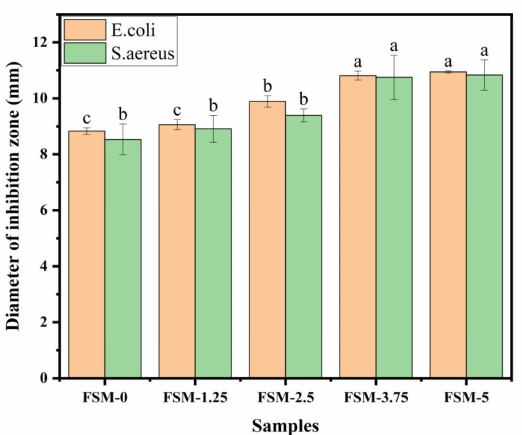
Figure 6. Antibacterial activity of composite films incorporated with different MAA ratios.